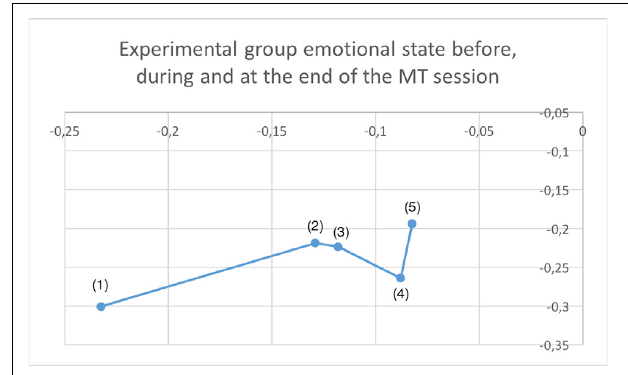
FIGURE 5 | Plot in the arousal/valence plane for the averaged estimated emotional state of participants in the EG during one session: initial state (1), receptive song (2), active song (3), receptive imaginative intervention (4), and final state